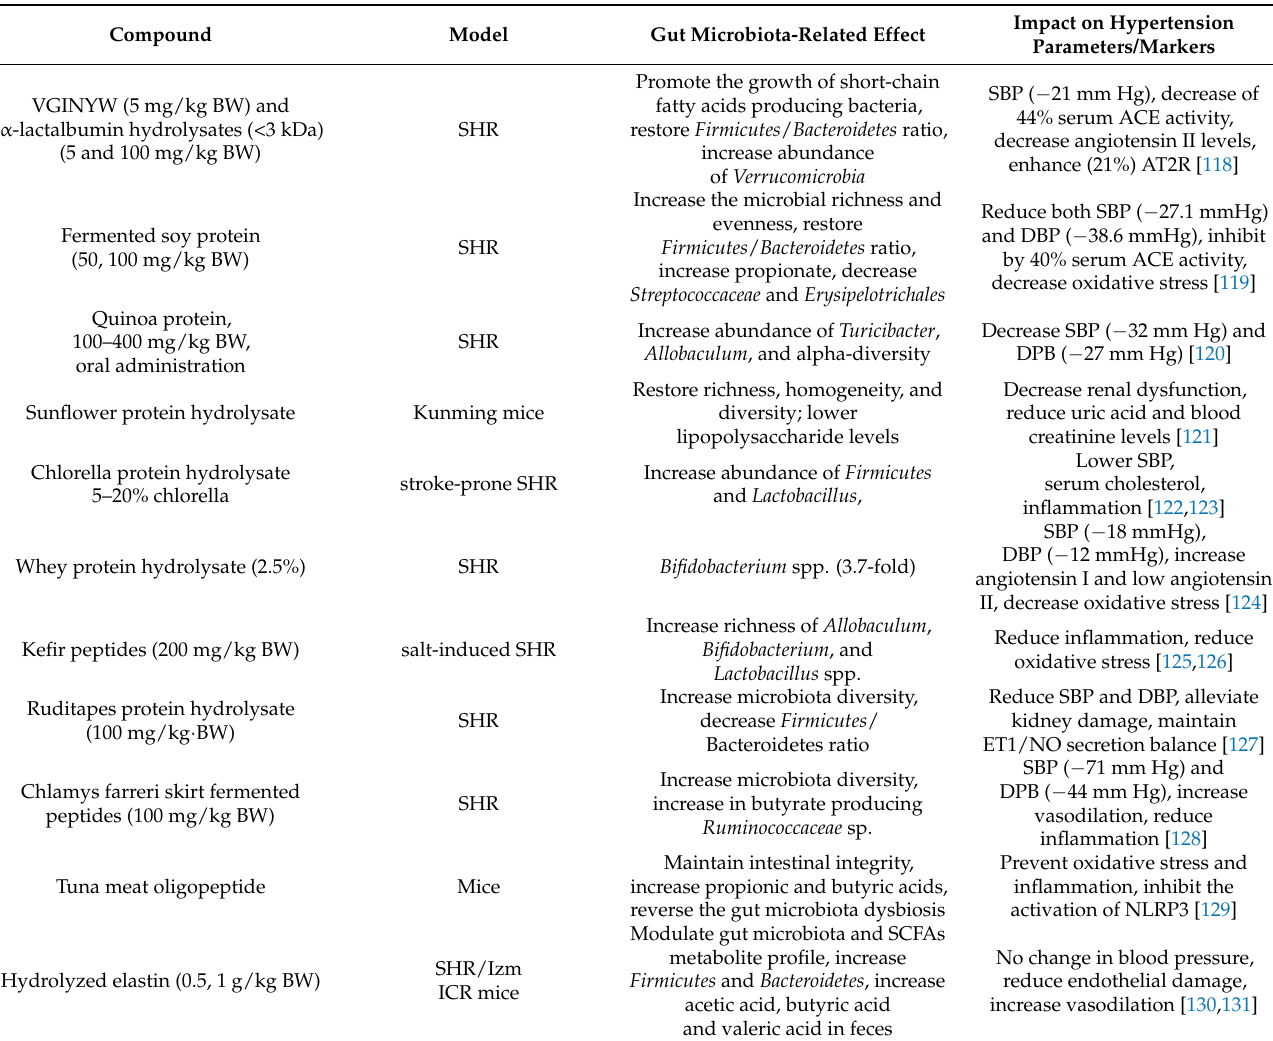
Table 1. The effects of protein hydrolysates/peptides on gut microbiota modulation and hypertension. SHR: spontaneously hypertensive rats, ACE: angiotensin-converting enzyme, Systoic (SBP) and diastolic (DBP) blood